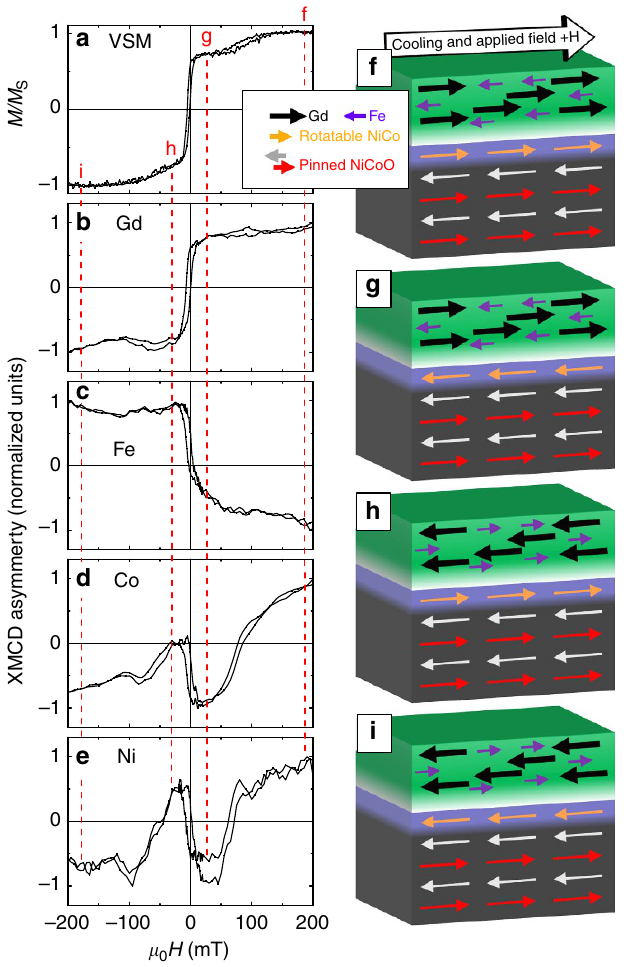
Figure 3 | Collective and element-specific magnetic hysteresis loops. Room-temperature hysteresis loops of sample A ( x ¼ 0.42, with a Cu capping layer) measured by ( a ) VSM and element-specific XMCD for ( b ) Gd, ( c ) Fe, ( d ) Co and ( e ) Ni. Schematic illustrations of the sample magnetic configuration at various stages of the reversal are shown in f – i , respectively. In the layer structure, from top to bottom, the layers are GdFe (green), GdO y and GdFe mixture (white), NiCo (blue) and NiCoO (black), respectively. Arrows in the layers indicate the magnetization directions. NATURE COMMUNICATIONS|7:11050|DOI: